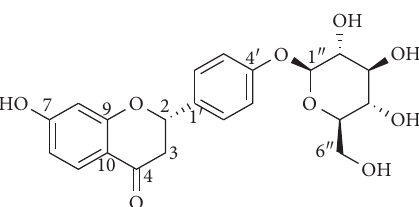
Figure 1: Structure of liquiritin (LIQ) from Radix Glycyrrhizae